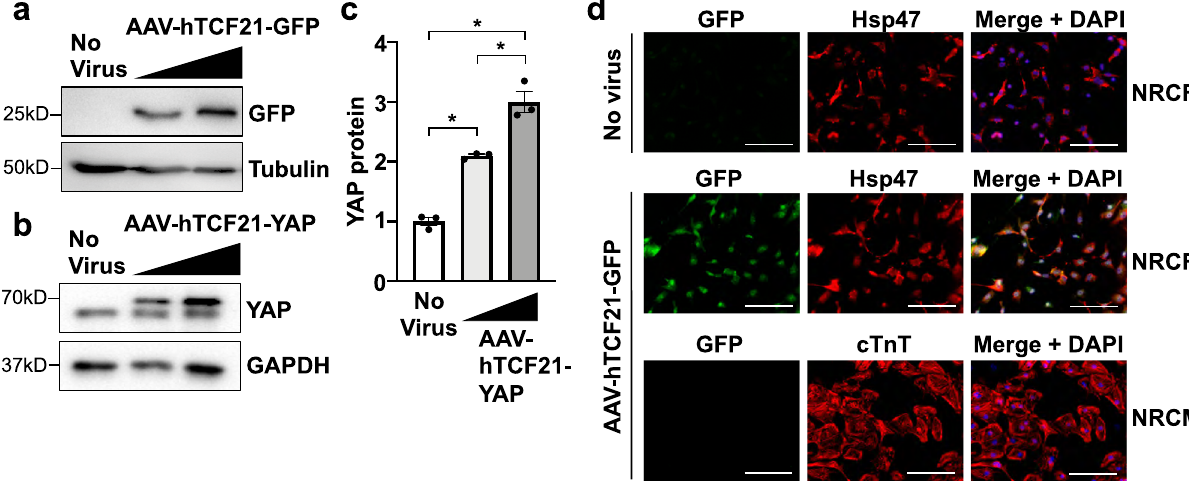
Figure 1. Characterization of AAV-hTCF21-GFP and AAV-hTCF21-FLAG-YAP expression in vitro. ( a–c ) Primary neonatal rat cardiac fibroblasts (NRCFs) were transduced with AAV-hTCF21-GFP or AAV-hTCF21- FLAG-YAP at 1 × 10 9 or 3 × 10 9 vg. The untreated (No virus) cells were used as controls. GFP or YAP was detected by western blot 24 h after virus addition. ( c ) Total YAP expression was quantified by densitometry. ( d ) NRCFs or neonatal rat cardiomyocytes (NRCMs) were transduced with AAV-hTCF21-GFP or untreated controls. GFP, Hsp47, or cardiac troponin T (cTnT) was visualized by fluorescence microscopy 3 days after virus addition. Scale bar, 100 μm. N = 3 experimental replicates. *p < 0.05. Full-length blots are presented in Supplementary Fig.